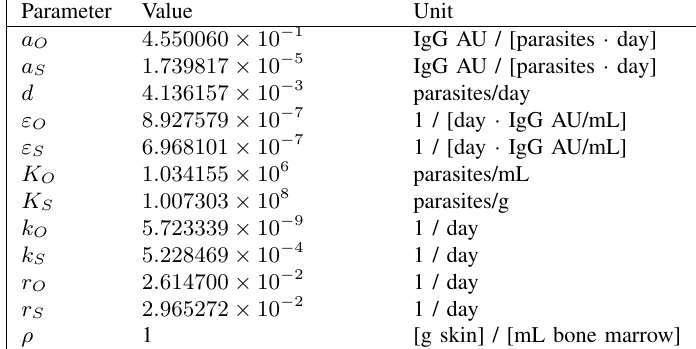
TABLE II: Parameter values used.